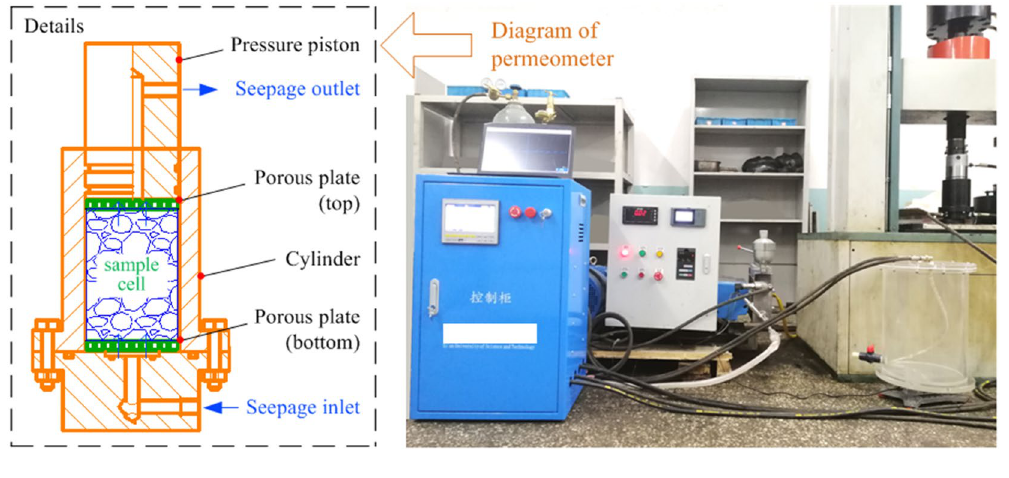
Figure 2. Sample installation